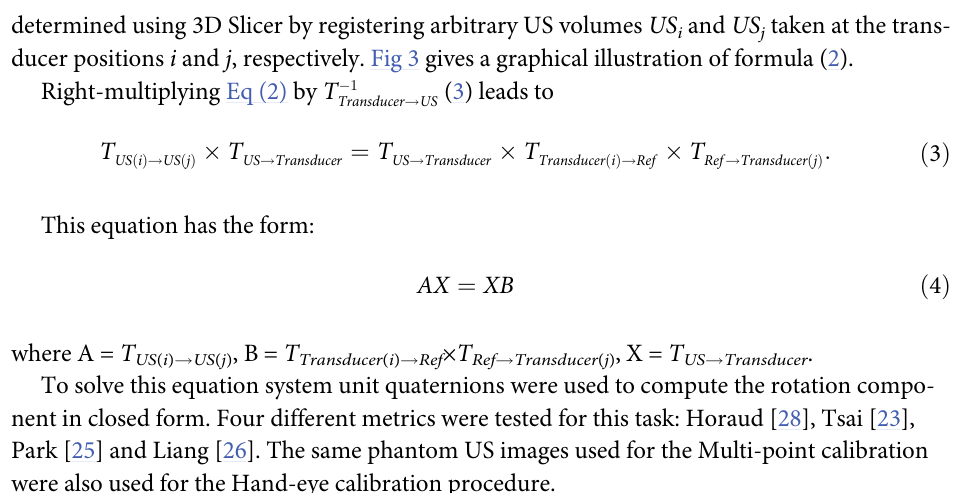
Fig 3. Hand-eye US calibration loop: The transformation between arbitrary US volumes US i and US j can be found indirectly via the tracked sensor positions or directly via 3D intra-modality image registration.